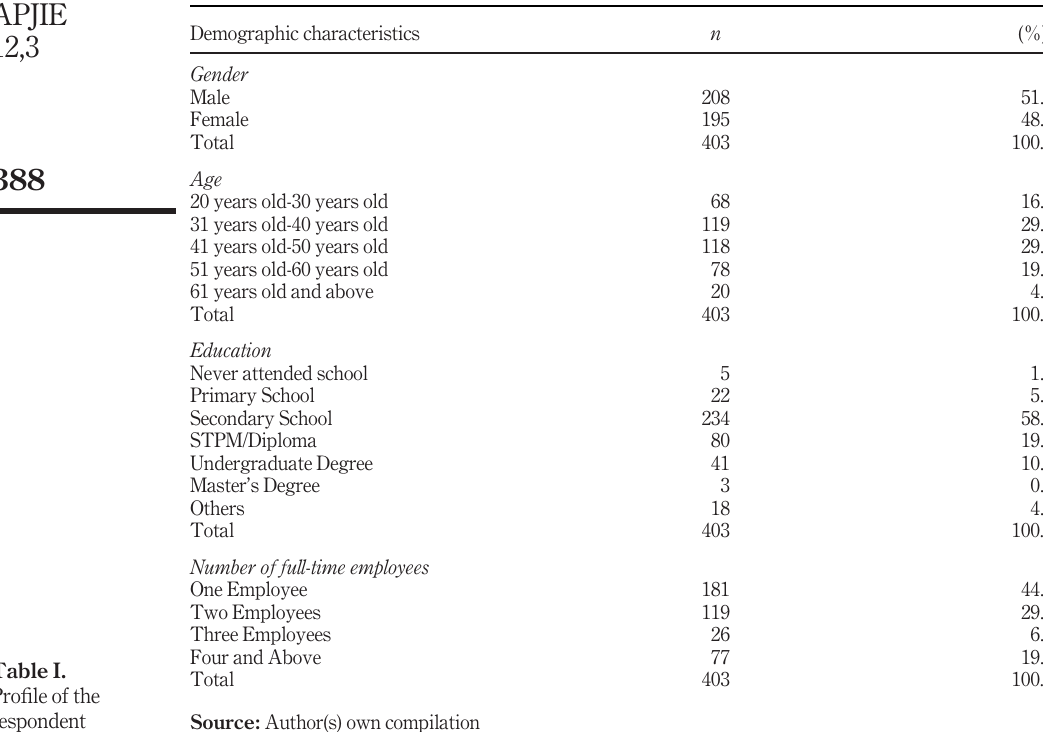
Table I. Pro fi le of the